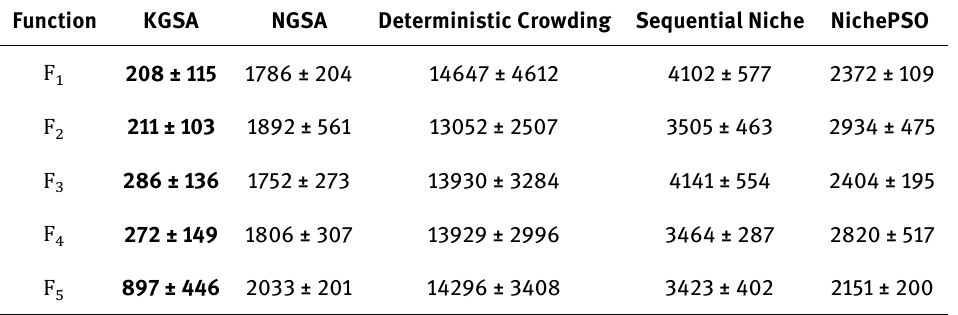
Table 7: Average number of fitness function assessments needed to converge for each niching algorithm for functions F 1 to F 5 . The results were averaged after thirty independent runs of